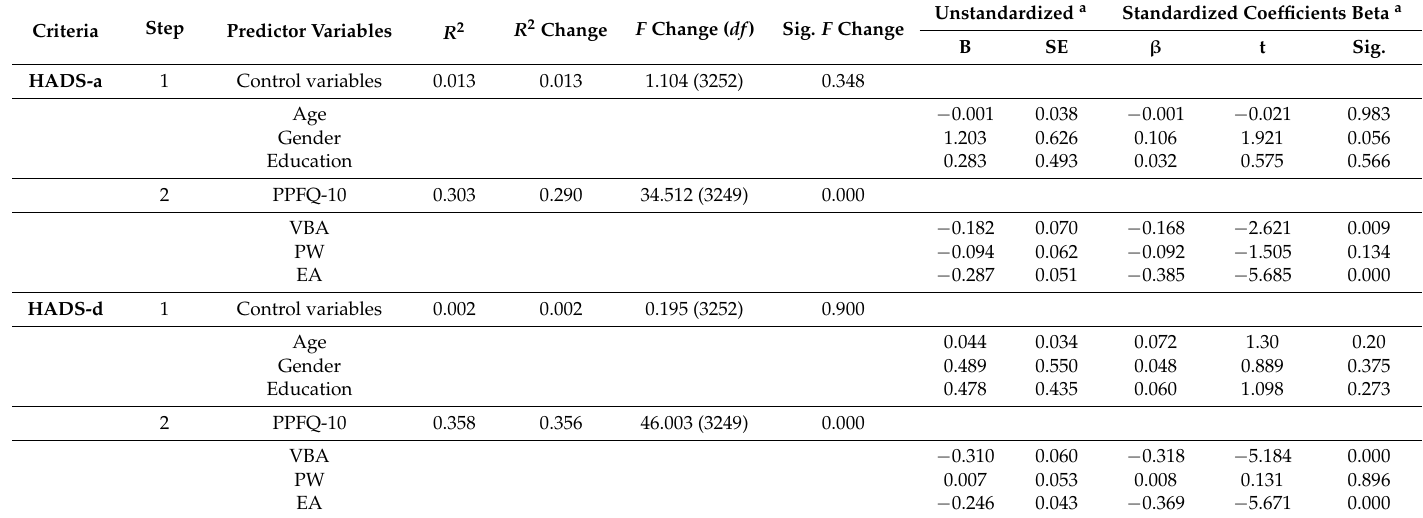
Table 4. Hierarchical regression analysis to evaluate the criteria validity of the